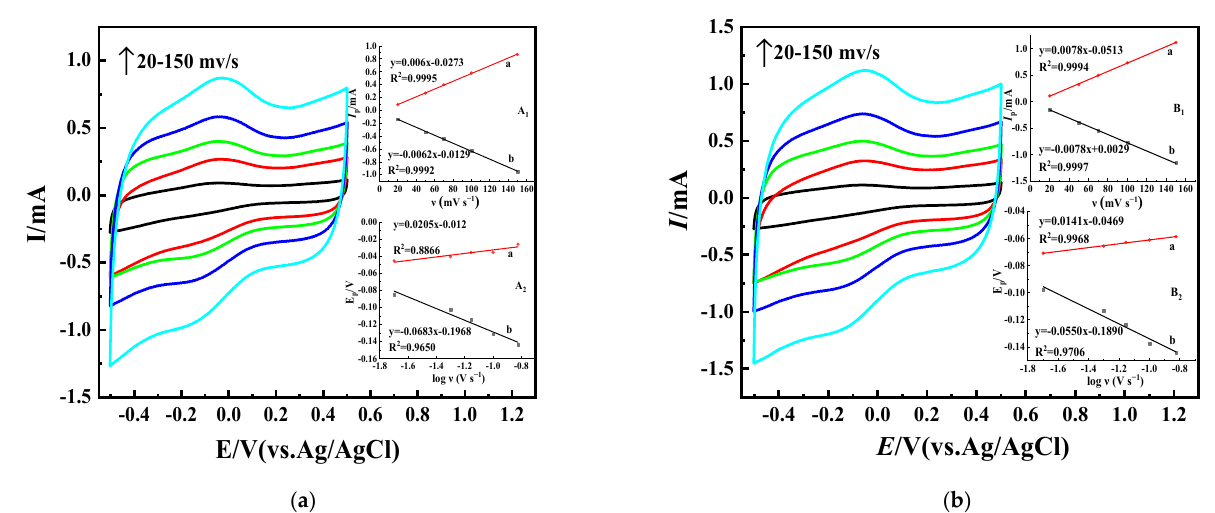
Figure 8. ( a ) CVs of Nafion/GOx/OMC-COOH at different scan rates (20–150 mV·s − 1 ); insets (A 1 and A 2 ) are plots of anodic and cathodic peak currents vs. scan rate and peak potentials vs. log-scan rates, respectively. ( b ) CVs of Nafion/GOx-NH 2 /OMC-COOH at different scan rates (20–200 mV·s − 1 ); insets (B 1 and B 2 ) are plots of anodic and cathodic peak currents vs. scan rate and peak potentials vs. log-scan rates, respectively.